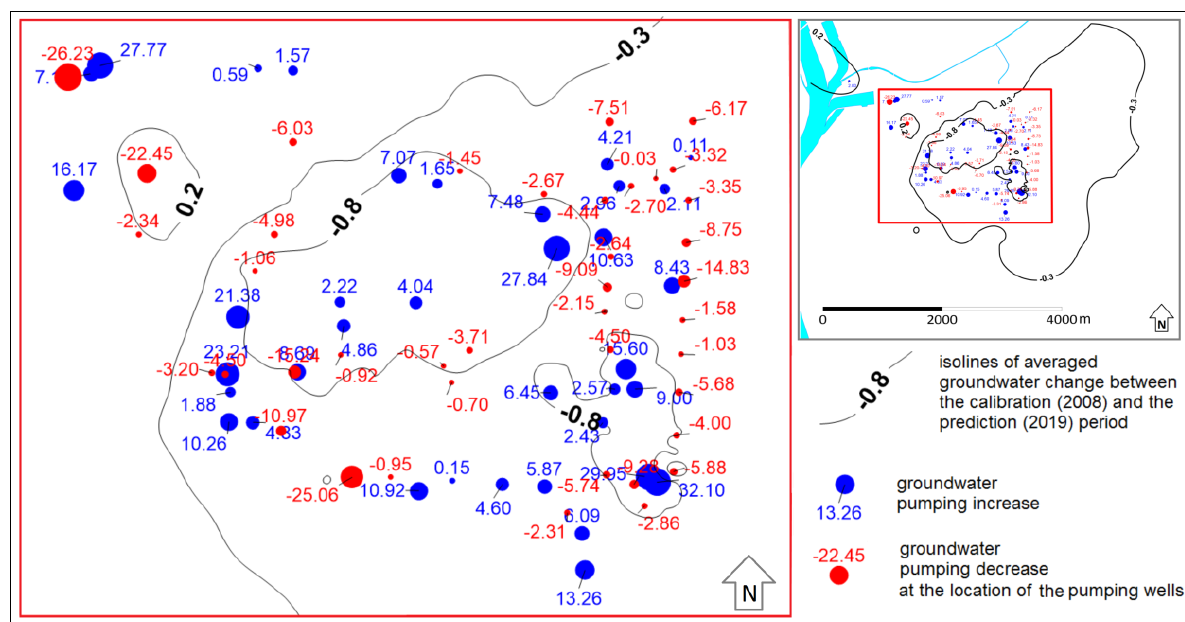
Figure 5. Differences in averaged observed groundwater head (contours) and averaged pumping